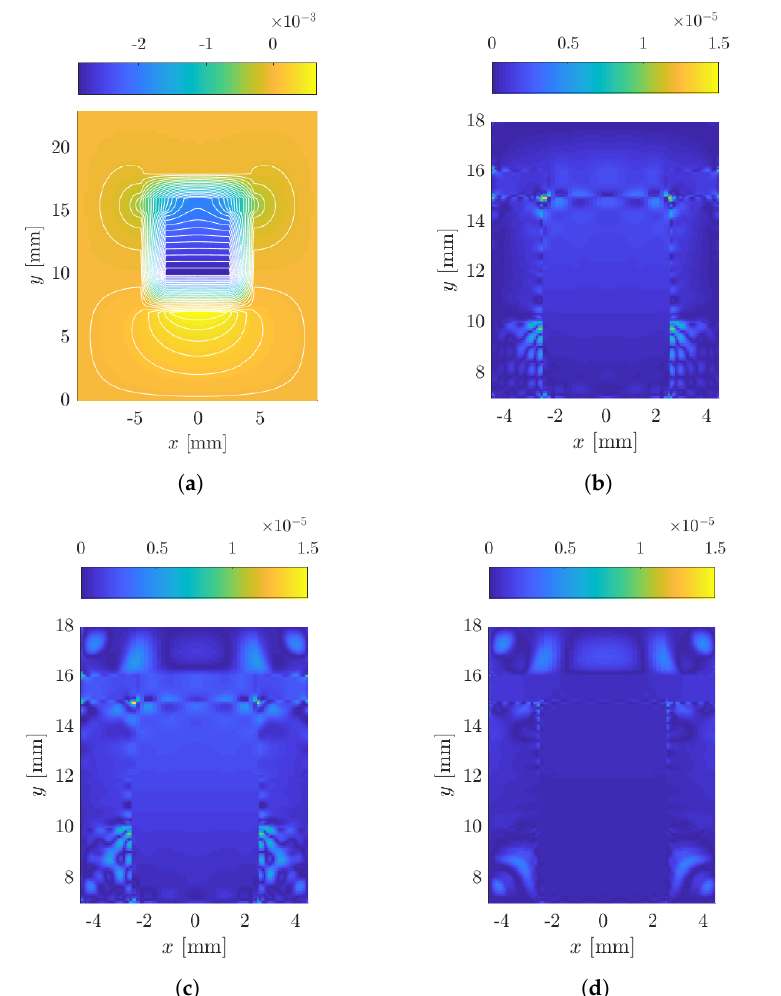
Figure 6. ( a ) Magnetic potential distribution in [Vs/m] and isolines obtained with IGA, ( b – d ), show the nodal differences between IGA-SEM, IGA-FEM, SEM-FEM reference solutions obtained with SI.